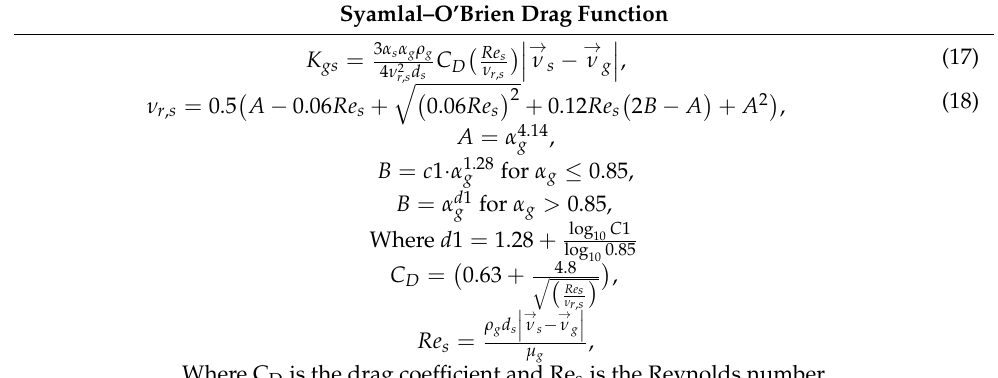
Table 3. Momentum exchange